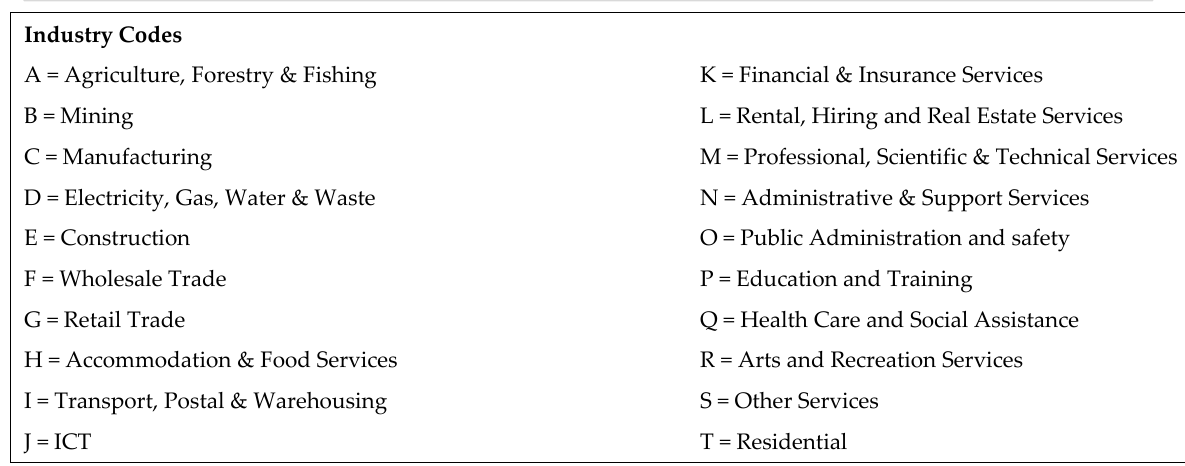
Figure 1. Internal floor space, employment, business establishments, and workspace ratio, by industry division in central Sydney, 2006, 2011, and 2017.